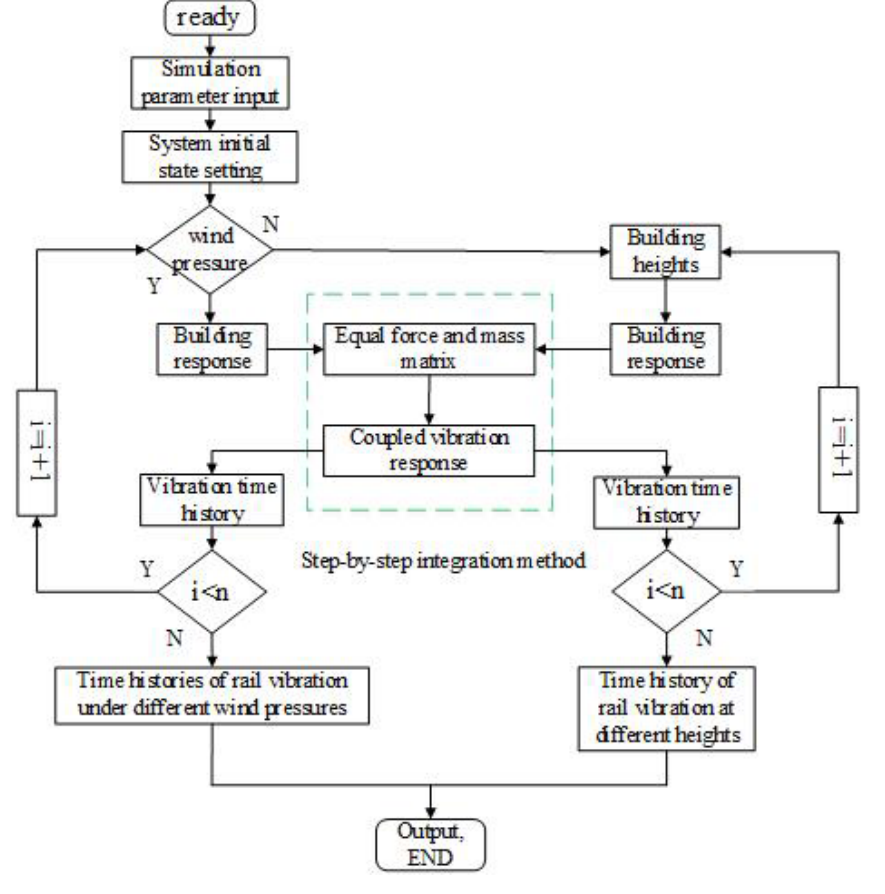
Figure 2. Flow chart of the simulation calculation.